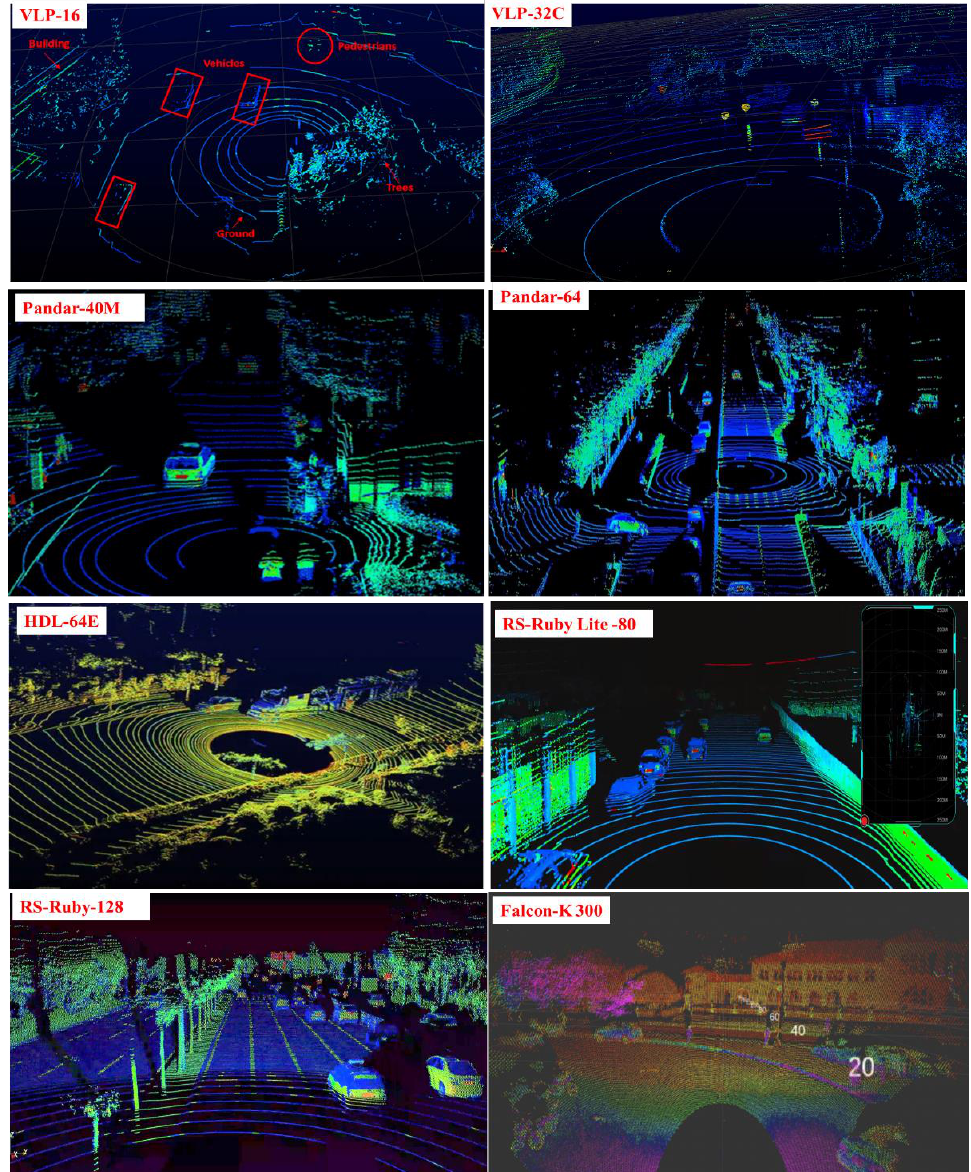
Figure 2. Point cloud of the typical LiDAR.